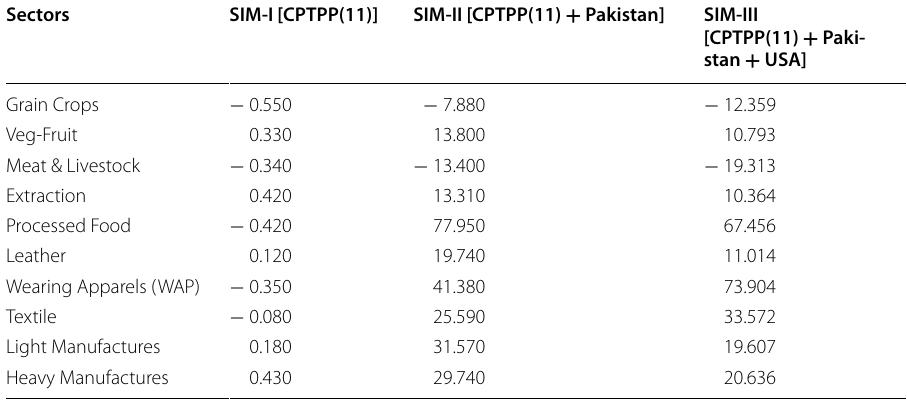
Table 5 Impact of CPTPP on sectorial exports of Pakistan Source : Author’s simulation Sectors